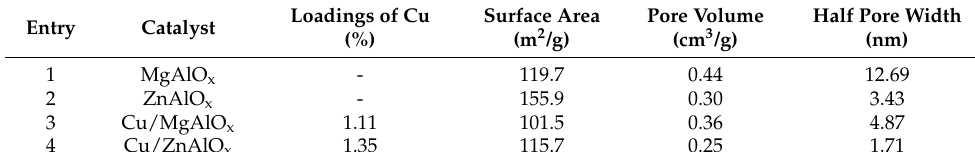
Table 2). The isotherms and BJH pore size distribution curves are displayed in Figure 2. From the results, MgAlO x and ZnAlO x showed S BET of 119.7 and 155.9 m 2 /g, respectively. However, as Cu species was added, a decrease in S BET and pore volume were observed Table 2. Textural properties of mixed oxides and supported Cu catalysts. in Cu/MgAlO x and Cu/ZnAlO x catalysts, which could be attributed to the deposition of Cu species inside the pores of mixed oxides. Furthermore, the isothermal curves of above samples show obvious type IV hysteresis loops according to IUPAC classification, indicating the presence of porous structure in the above samples [36,37]. Additionally, the contents of Cu for the Cu/MgAlO x and Cu/ZnAlO x catalysts were measured by inductively coupled plasma atomic emission spectroscopy (ICP-AES), with the similar values of 1.11 wt.% and 1.35 wt.%, which also agreed well with the nominal values. Table 2. Textural properties of mixed oxides and supported Cu catalysts. Loadings of Cu Surface Area Entry Catalyst (%) (m 2 /g)